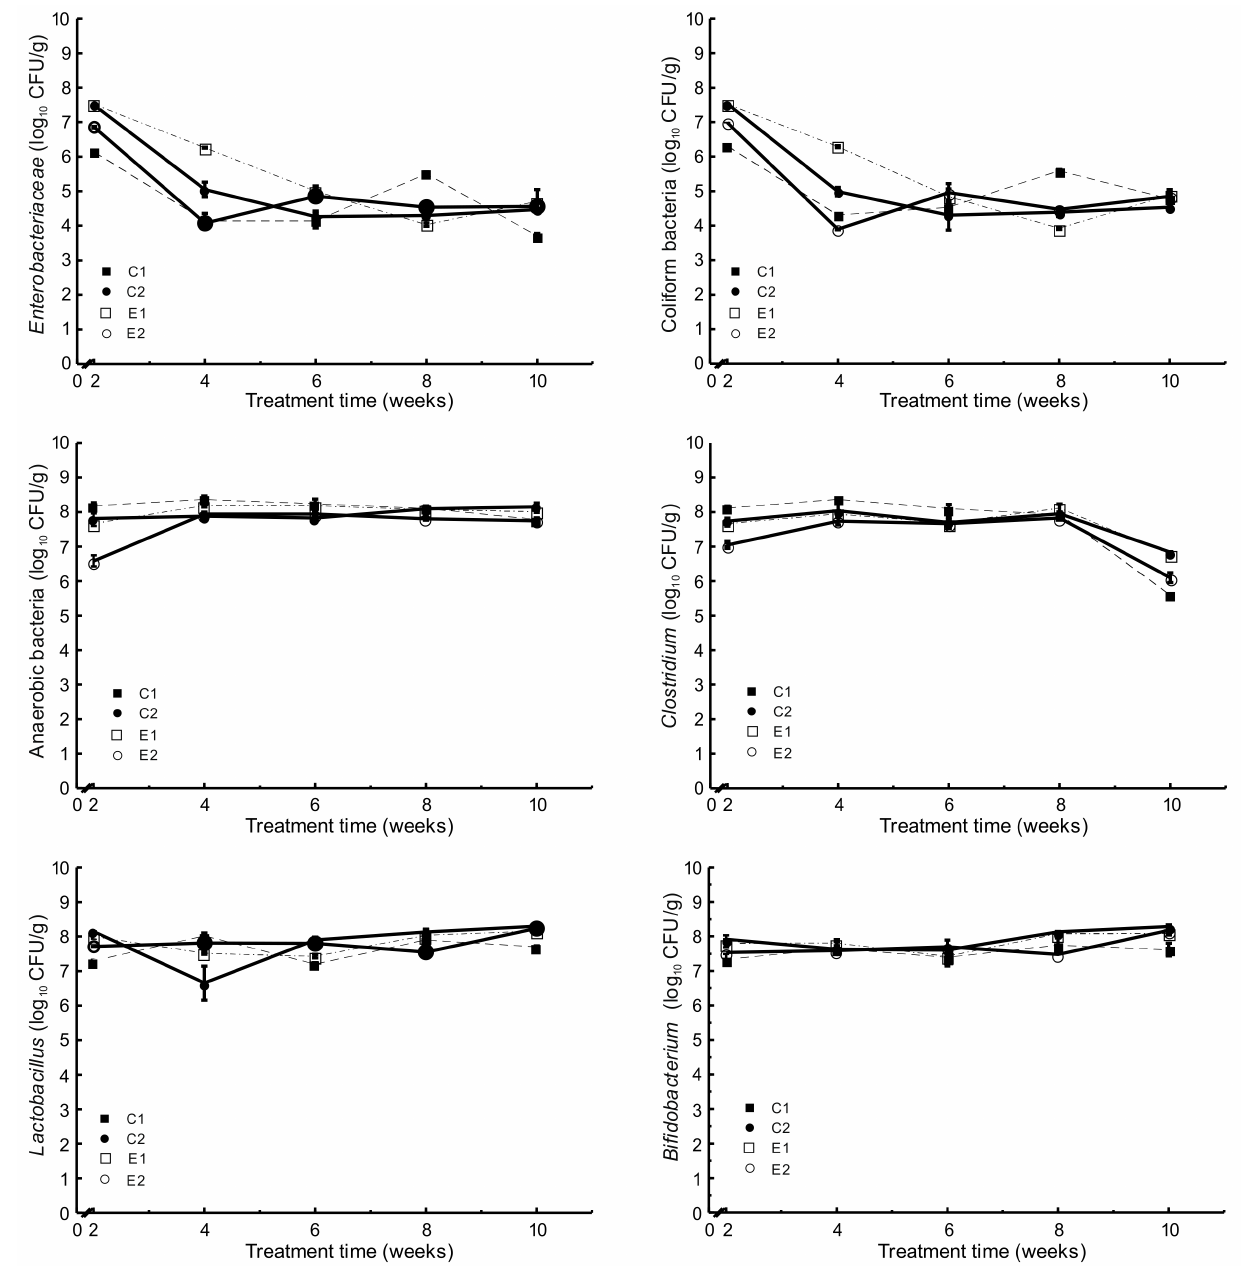
Figure 3. Microbial counts in stool samples collected during the experimental period (mean and SD, n = 6): C1 wild- type mice fed a standard diet, C2 Apc Min/+ fed a standard diet, E1 Apc Min/+ fed a standard diet supplemented with microencapsulated Bf and Lg , E2 Apc Min/+ fed a standard diet supplemented with microencapsulated Bf , Lg, and quercetin. The count of Enterobacteriaceae in stool samples was decreased from 10 7 CFU/g (2nd week) to 10 4 CFU/g (10th week) (Figure 3). Similarly, the count of Coliform bacteria was decreased from 10 7 CFU/g (2nd week) to 10 4 CFU/g (10th week). No other significant differences were observed between the four experimental groups. However, animals sup- plemented with microencapsulated probiotics and quercetin (E2) showed increased counts ( p < 0.05) of Bifidobacterium and Lactobacillus population in the caecum content compared to both C1 and C2 (Figure